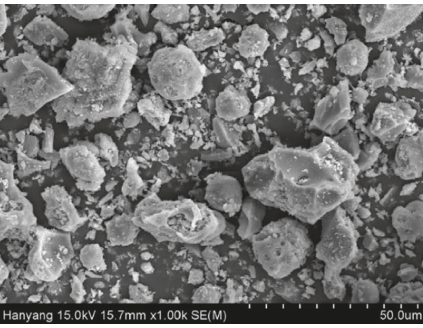
Figure 2: SEM image of